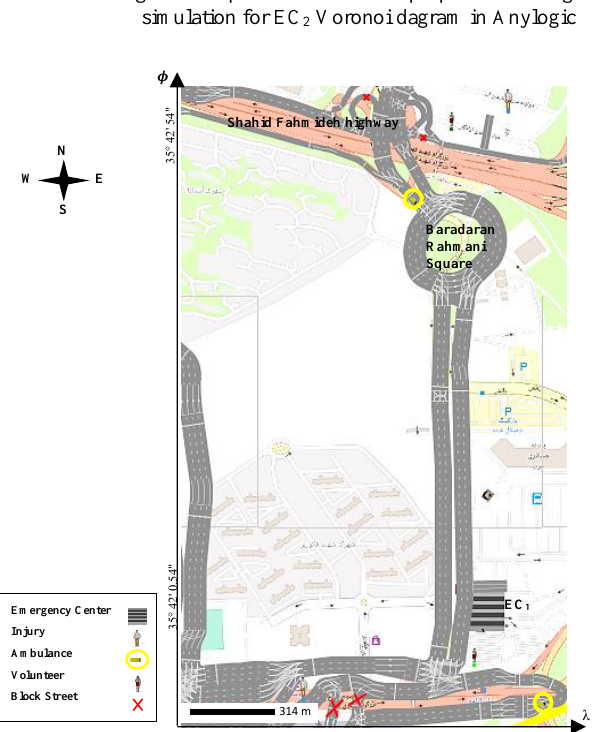
Figure 7. Implementation of proposed multi agent simulation for EC 1 Voronoi dagram in Anylogic